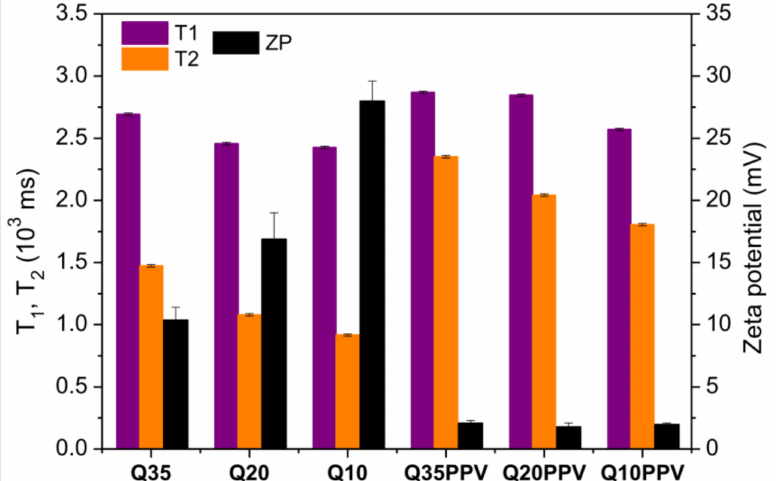
Figure 3. Longitudinal (T 1 ) and transversal (T 2 ) relaxation times calculated from TD-NMR signal data, and zeta potential values of NPs and NCPs.